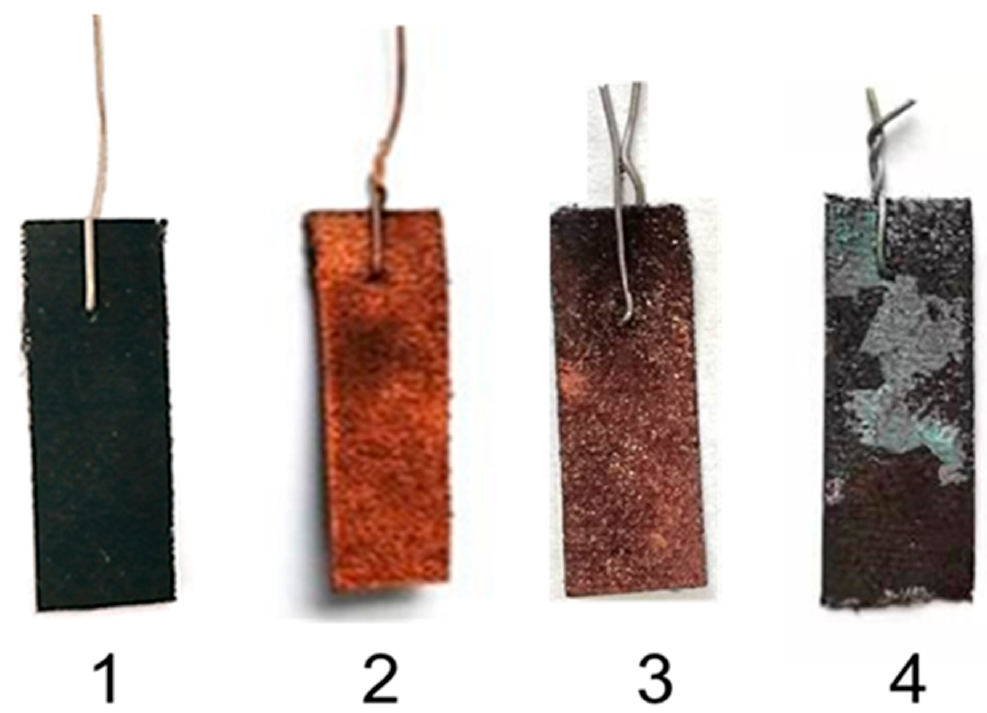
Figure 7. Cathode color after simulated AMD treatment with dual-chamber MFCs with electroactive biofilm at different pH (1: abiotic, 2: pH = 6.0, 3: pH = 5.0, and 4: pH = 4.0).